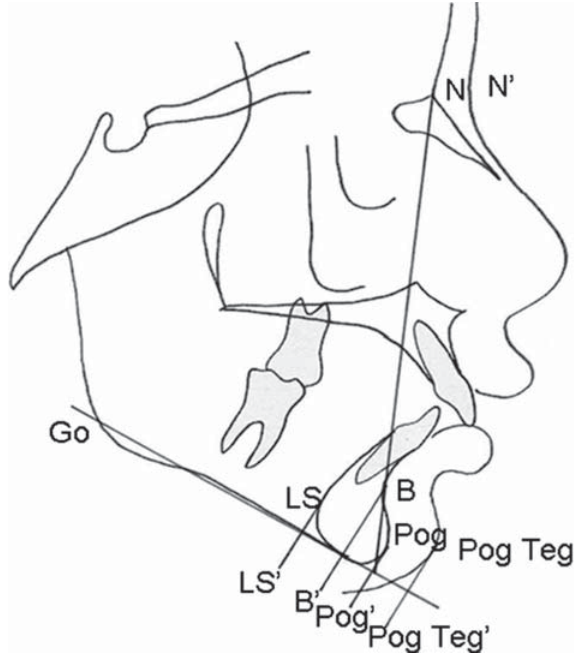
Figure 4- Nose cephalometric tracing with linear and angular